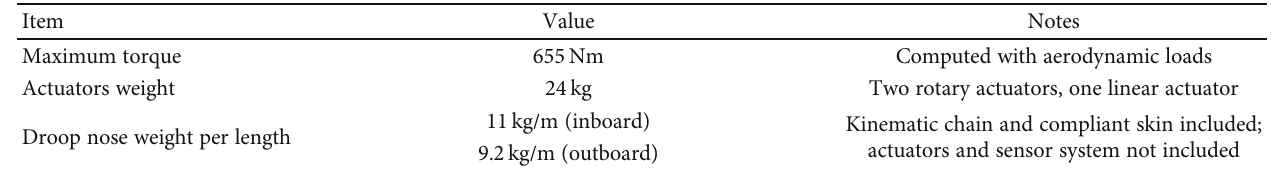
Figure 24: CAD model of the wing-box with the droop nose. Table 6: Actuation and weight results